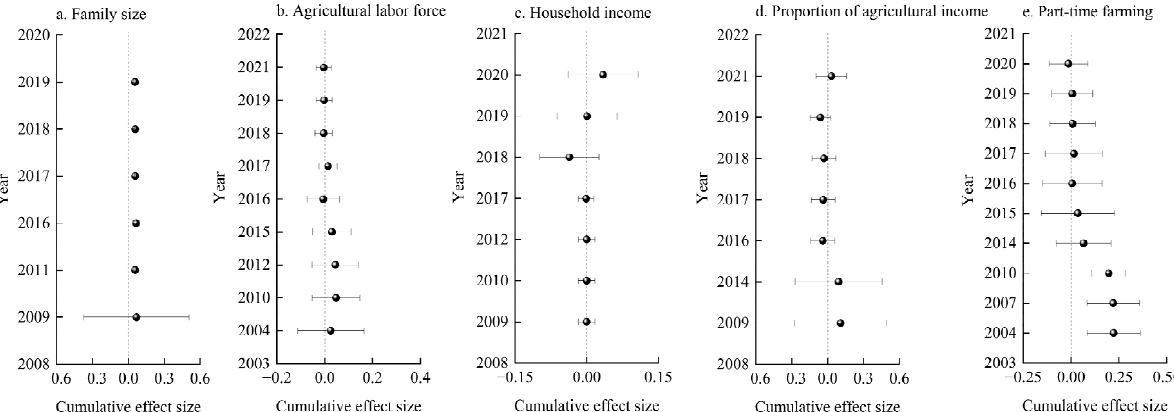
Figure 3. Cumulative meta-analysis trend (household characteristics).